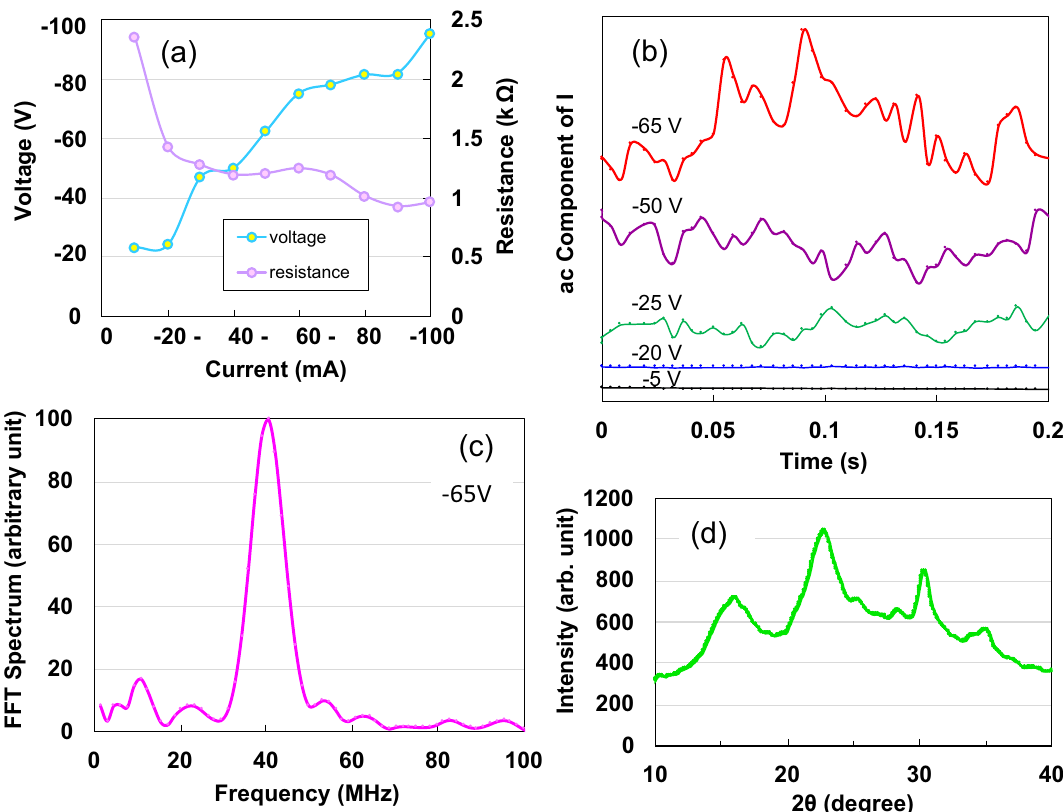
Figure 2. ( a) V-I and R-I characteristics from − 100 mA to 0 mA; ( b) AC voltage component across R std for various V values; ( c) FFT spectrum at 65 V; ( d) XRD analysis results of AKCF